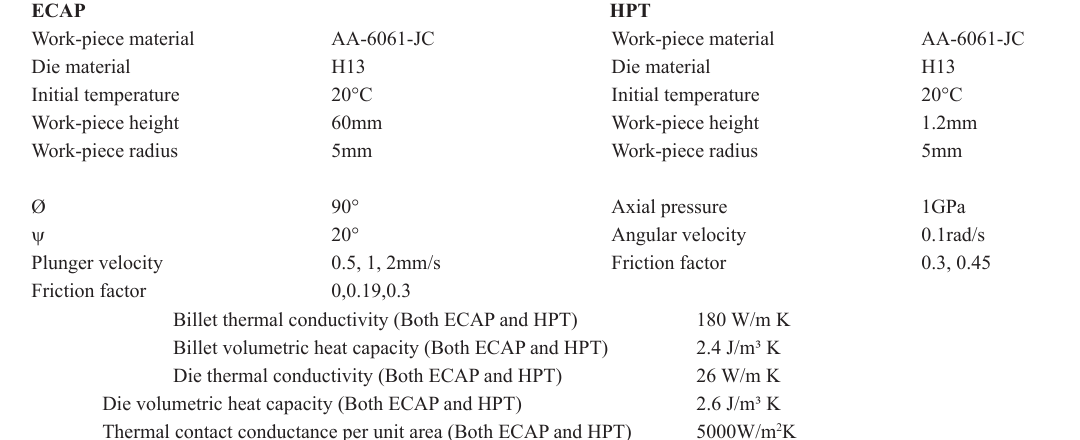
Table 1: Simulation conditions for ECAP and HPT ECAP HPT Work-piece